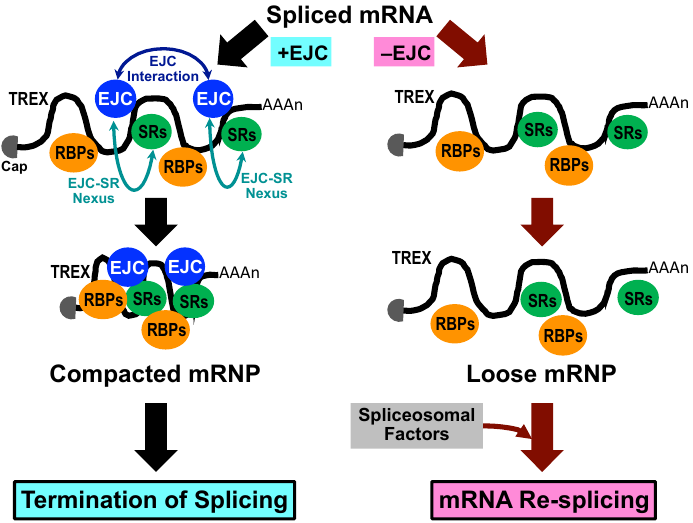
Figure 6. Model of the EJC-triggered pathway leading to the termination of splicing. The spliced mRNA was shown to form a packed and compacted mRNP structure by binding between EJC cores and among EJC and SR proteins (EJC-SR nexus) together with other RNA-binding proteins (RBPs) [20,21]. We assume that splicing-dependent binding of EJC core to mature mRNA is essential to initiate the formation of this highly compacted mRNP structure.